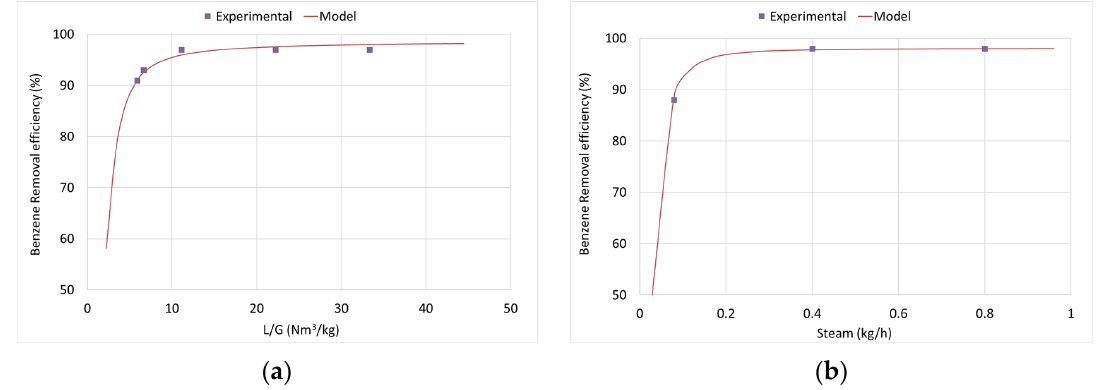
Figure 7. Experimental data of the benzene removal versus model calculations with ( a ) oil circulation and ( b ) steam.